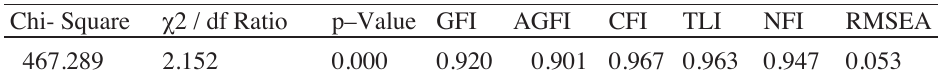
Fitness of the Model.